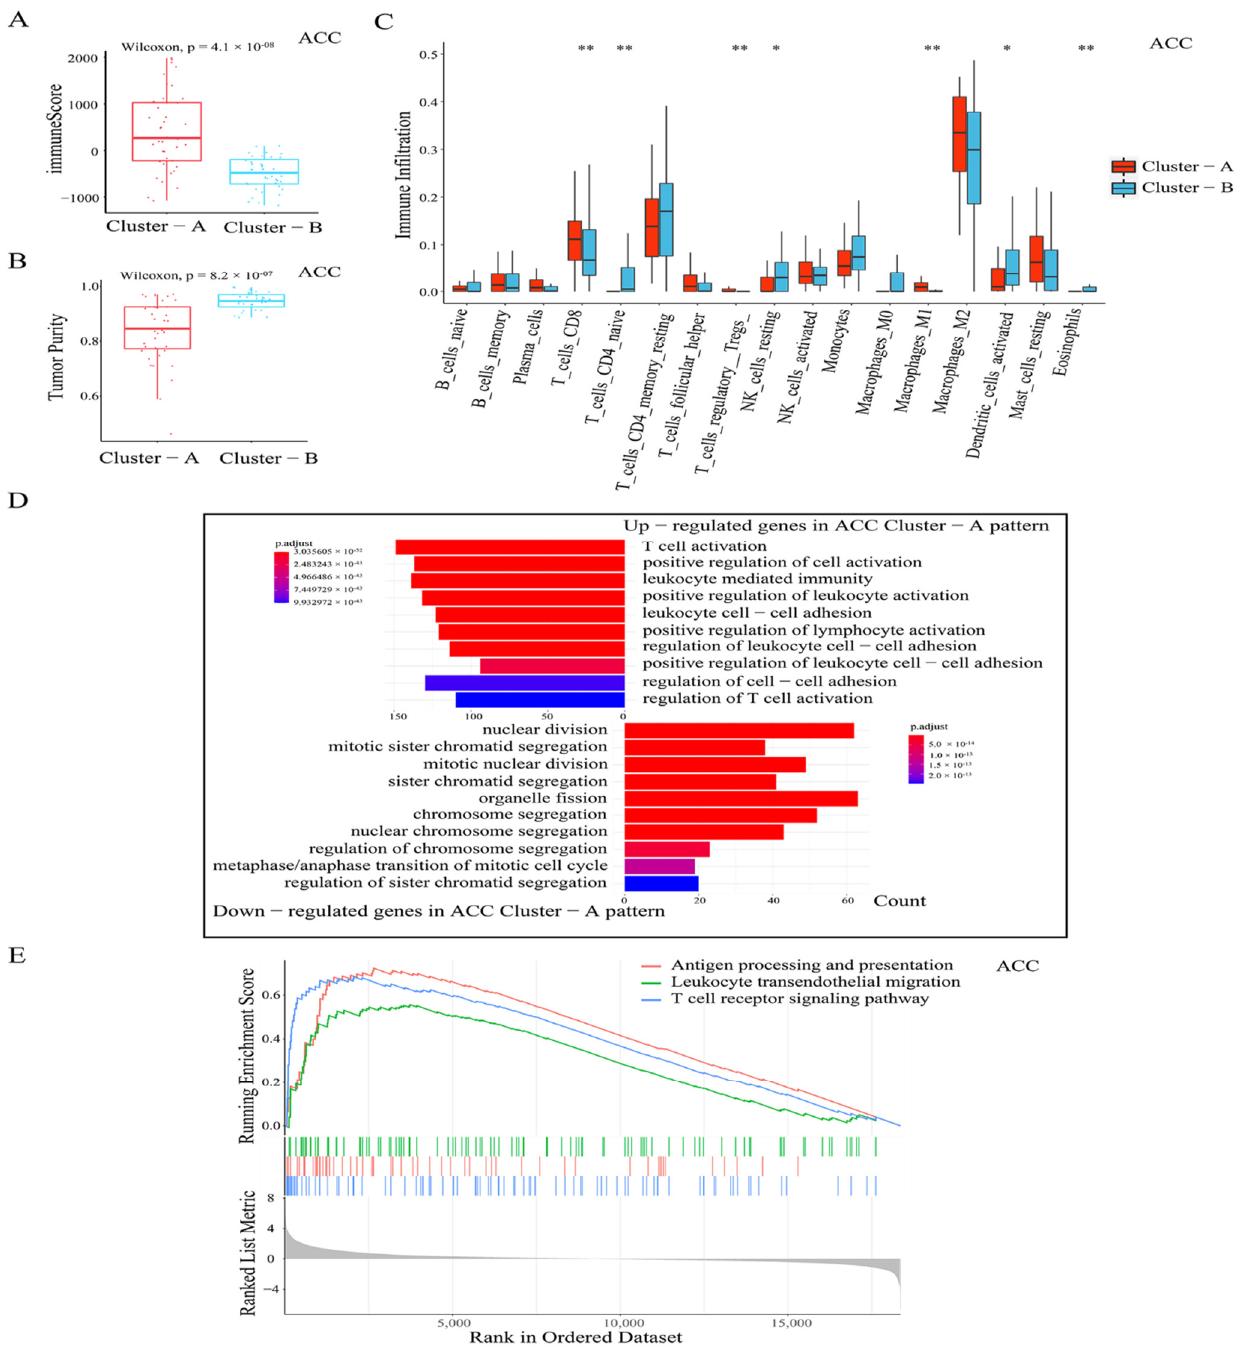
Figure 4. TME cell infiltration characteristics and transcriptome traits in the two patterns of APOBEC-mediated stratification in ACC. Evaluation of immune scores ( A ) and tumor purity ( B ) between the two patterns of APOBEC-mediated stratification in ACC; ( C ) Box plots show the abundance of each TME infiltrating cell in the two APOBEC-mediated patterns in ACC. The asterisks represented the statistical p value (* p < 0.05; ** p < 0.01); ( D ) Functional annotation for DEGs of the two APOBEC- mediated patterns of ACC using GO enrichment analysis. The upper bar plots graph shows the top 10 GO terms results of upregulated genes in Cluster-A pattern tumors in ACC. The lower bar plots graph shows the top 10 GO terms results of downregulated genes in Cluster-A pattern tumors in ACC; ( E ) Gene set enrichment analysis (GSEA) of three immune activation-related pathways enriched in